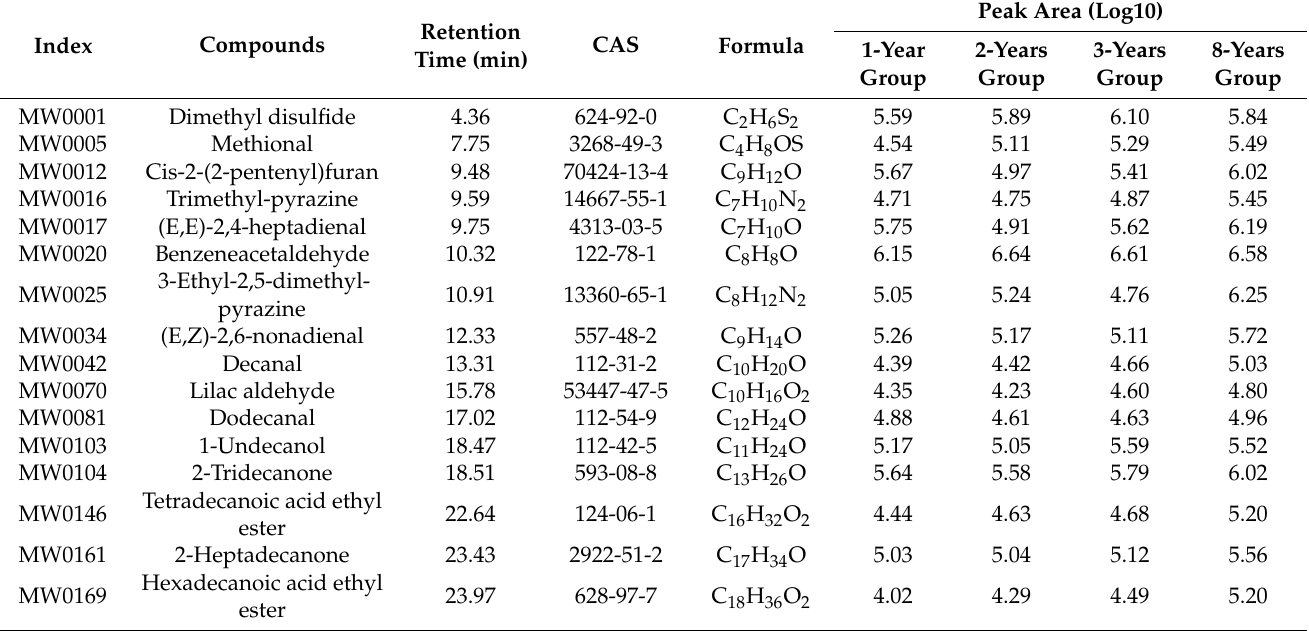
Table 4. The up-regulated VOCs in shrimp paste fermented for 1, 2, 3, and 8